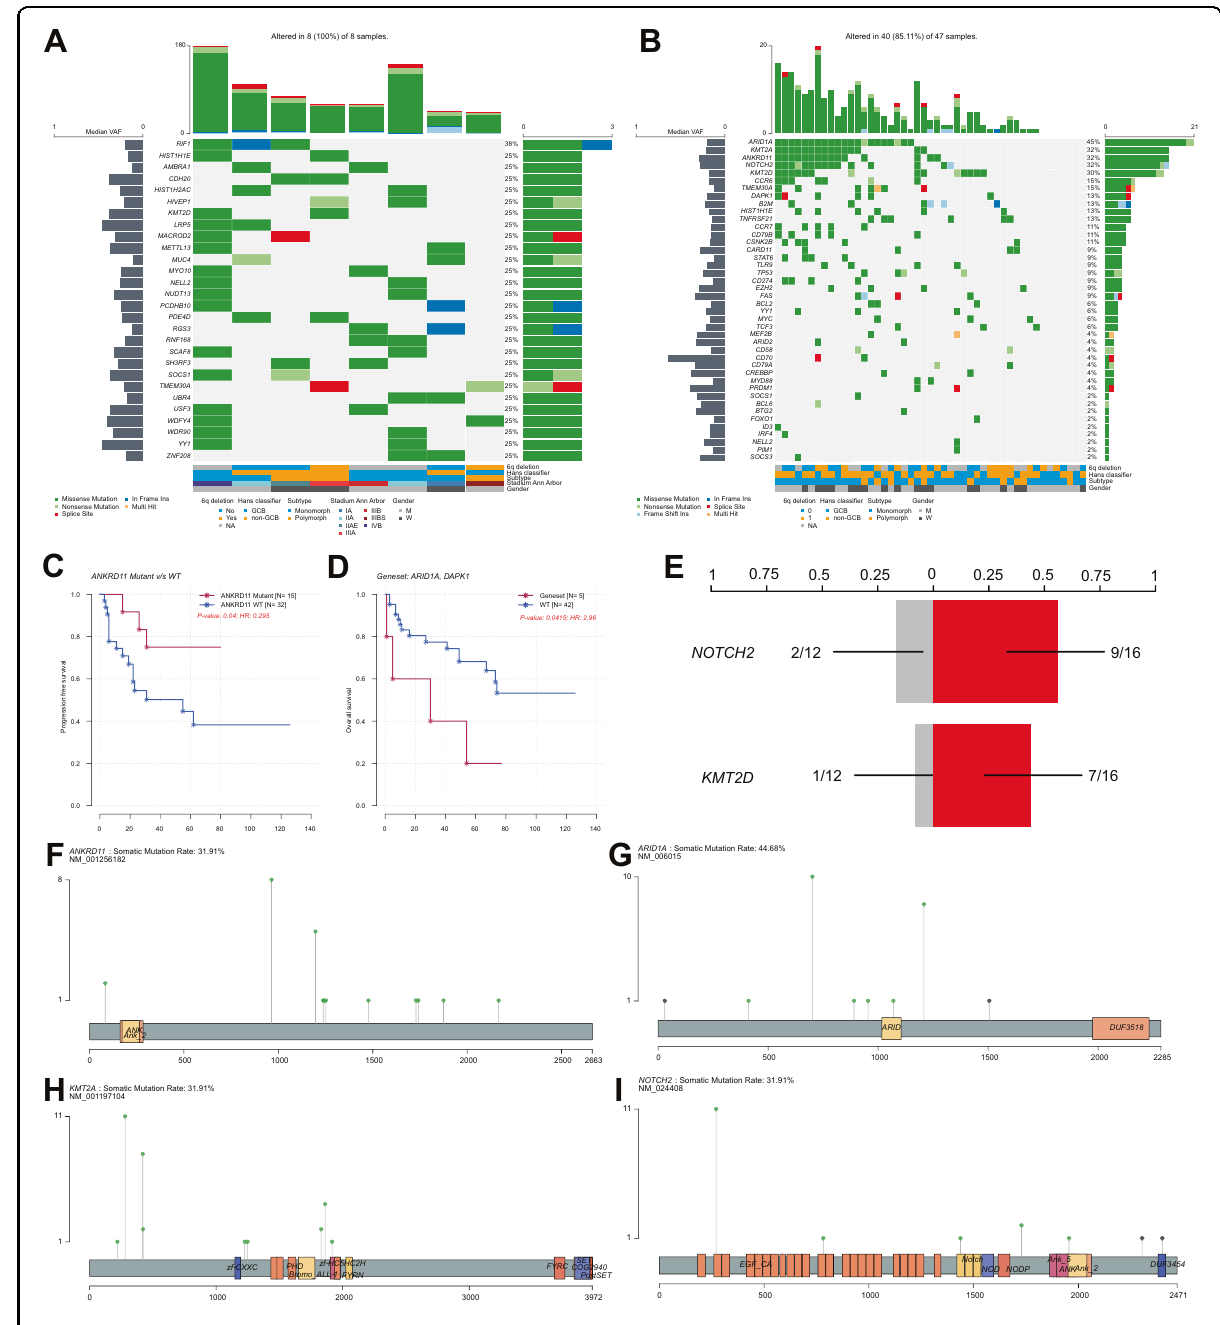
Fig. 3 Mutational signature of EBV + DLBCL (NOS). Panel ( A ) depicts an oncoplot of all genes harboring mutations in at least two samples of our discovery WGS cohort. Panel ( B ) illustrates the mutational landscape in our discovery and extension cohort of EBV + DLBCL (NOS) by tNGS. Mutations in ANKRD11 were identi fi ed as indicators of superior relapse-free but not overall survival ( C ). Moreover, distinct molecular subtypes exhibiting combined alterations of ARID1A and DAPK1 are shown to exhibit inferior overall survival ( D ). The corresponding endpoint analysis for ( C ) and ( D ) (overall survival for ANKRD11 mutation status and progression-free survival for our combined mutation set of ARID1A and DAPK1) is provided in Supplementary Fig. 7. For information on outcome according to these two mutational markers in the subset of R-CHOP treated patients, please see Supplementary Fig. 8. Further, we found mutations in both KMT2D as well as NOTCH2 to be signi fi cantly enriched in 6q wild-type patients ( E ). Lollipop plots illustrating the localized distribution of mutational patterns affecting ARID1A , KMT2A , ANKRD11 , and NOTCH2 in our combined cohorts; green dots refer to missense mutations; gray to truncating mutations ( F – I